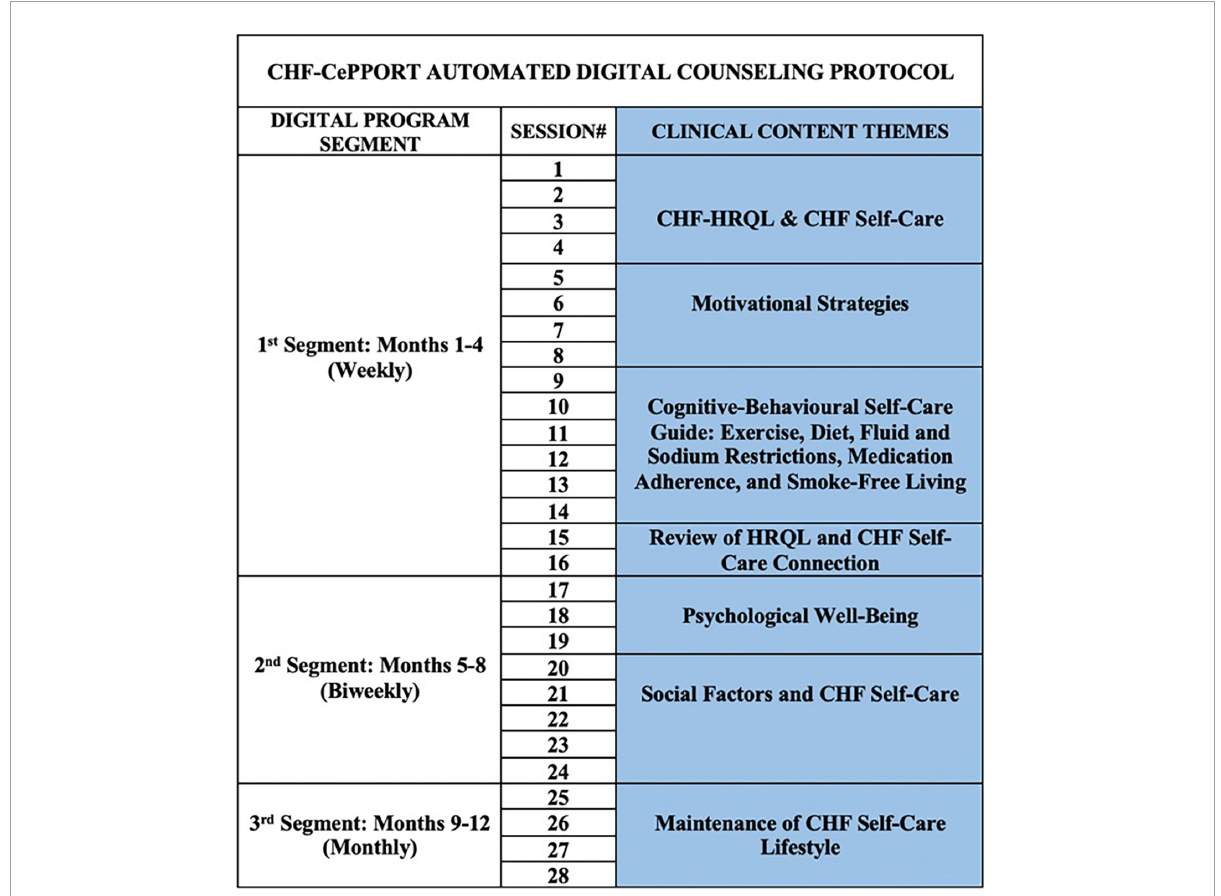
FIGURE1 CHF-CePPORT digital counseling protocol. CHF, chronic heart failure; HRQL, health-related quality of